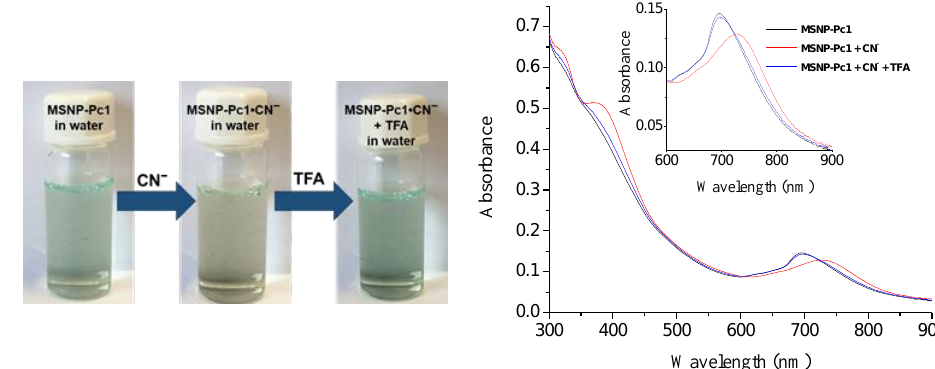
Figure 7. Colorimetric response of MSNP-Pc1 for reversibility and reusability tests with CN − ion